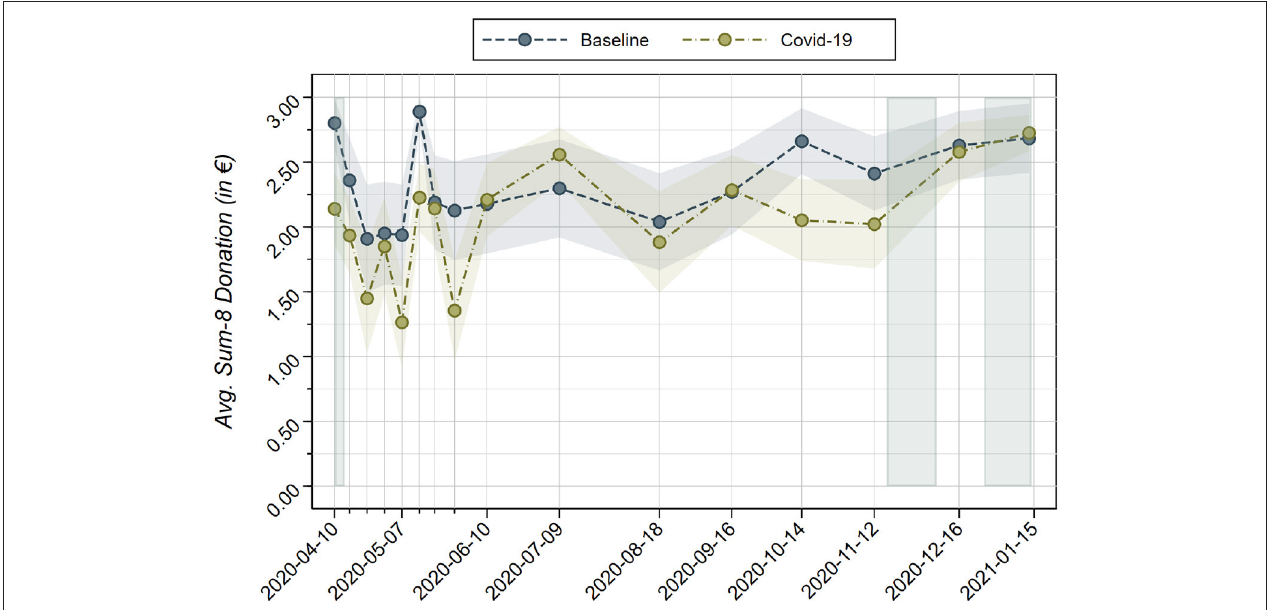
FIGURE 2 | Evolution of avg. sum-8 donations (in e ) in Baseline and COVID-19 per treatment over the eight consecutive weeks plus eight consecutive months of data collection. Shaded areas indicate 95% confidence intervals. Vertically shaded areas indicate lockdown periods. The differences (based on Tobit regressions of avg. sum-8 on a treatment indicator, with e 0 and e 3 as the lower and upper limit, respectively, and robust standard errors) between treatments Baseline and COVID-19 are insignificant for each date, except for 2020-04-10 [ t (75) = 4.094, p < 0.001], 2020-04-16 [ t (75) = 2.202, p = 0.031], 2020-05-07 [ t (69) = 2.501, p = 0.015], 2020-05-14 [ t (83) = 3.805, p < 0.001], 2020-05-28 [ t (68) = 2.644, p = 0.010], and 2020-10-14 [ t (73) = 3.343, p =